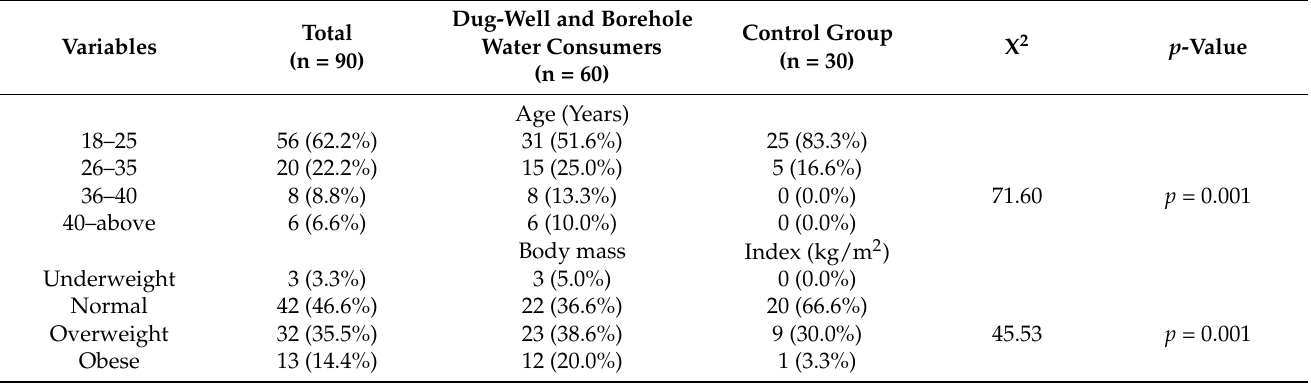
Table 1. Age and body mass index of hand-dug well/borehole water and treated water consumers.